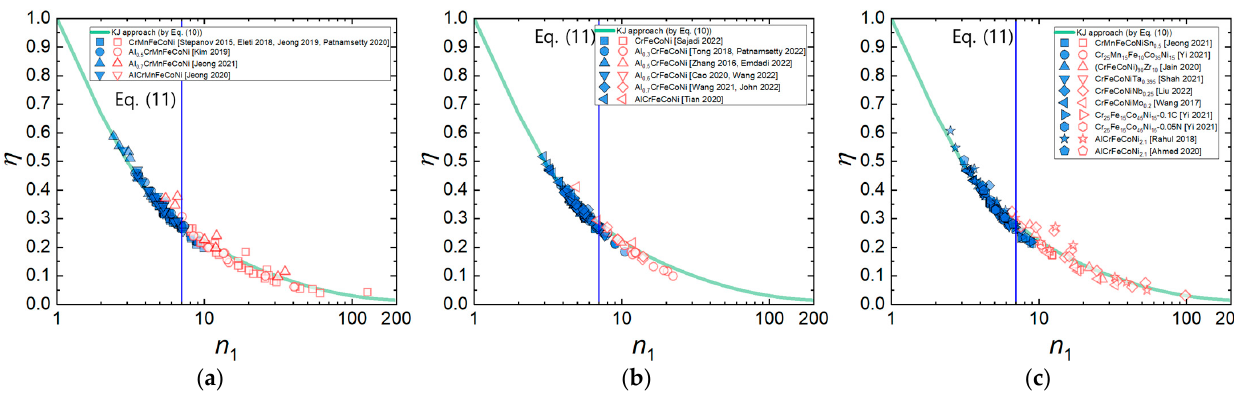
Figure 9. η values of the HEAs calculated by Murty’s method as a function of n 1 for ( a ) Al x CrMnFeCoNi ( x = 0–1) [9,23,27,34,42,45,63], ( b ) Al x CrFeCoNi ( x = 0–1) [13,25,51,53,72,84,92,96,97,100], and ( c ) CrMnFeCoNiSn 0.5 , etc. [18,22,47,54,60,61,64,70,89], which can be fitted by Equation (10). The (blue) solid and (red) open symbols represent the data points belonging to the flow stability and flow instability regimes, respectively, which is determined by Equation (9).